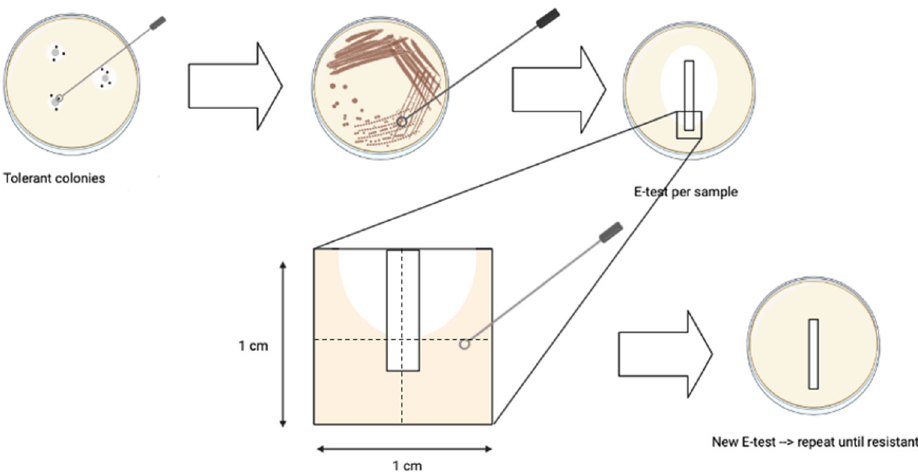
Figure 6. Parallel in vitro evolution of N. gonorrhoeae CRO tolerant colonies (n = 13) and non-tolerant sensitive cultures (n = 4) under selective pressure to induce CRO resistance through 7 consecutive crossover CRO E-tests.